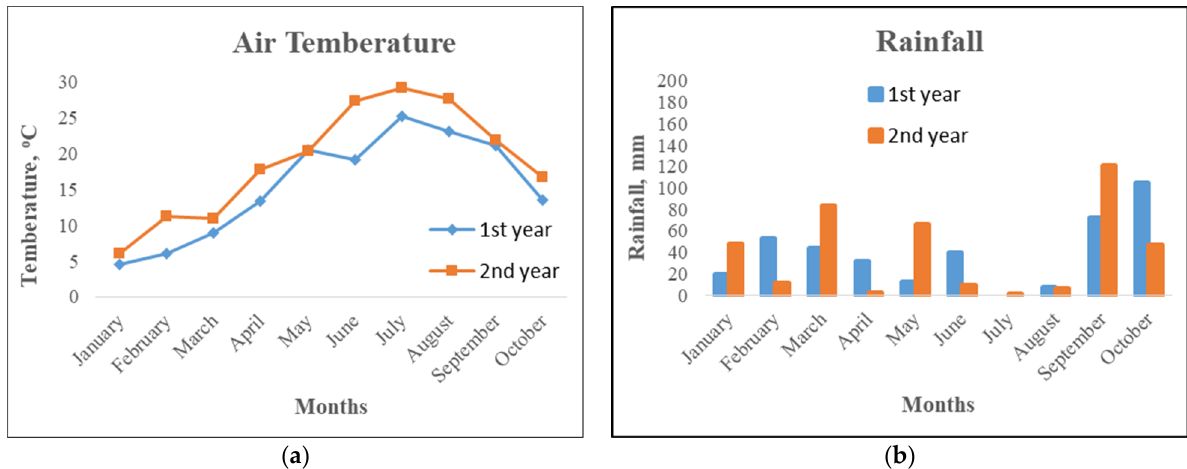
Figure 1. Average monthly air temperature ( a ) and total rainfall ( b ) occurring in the studied area during the growing periods (1st and 2nd growing years). Table 1. Physicochemical properties of the used